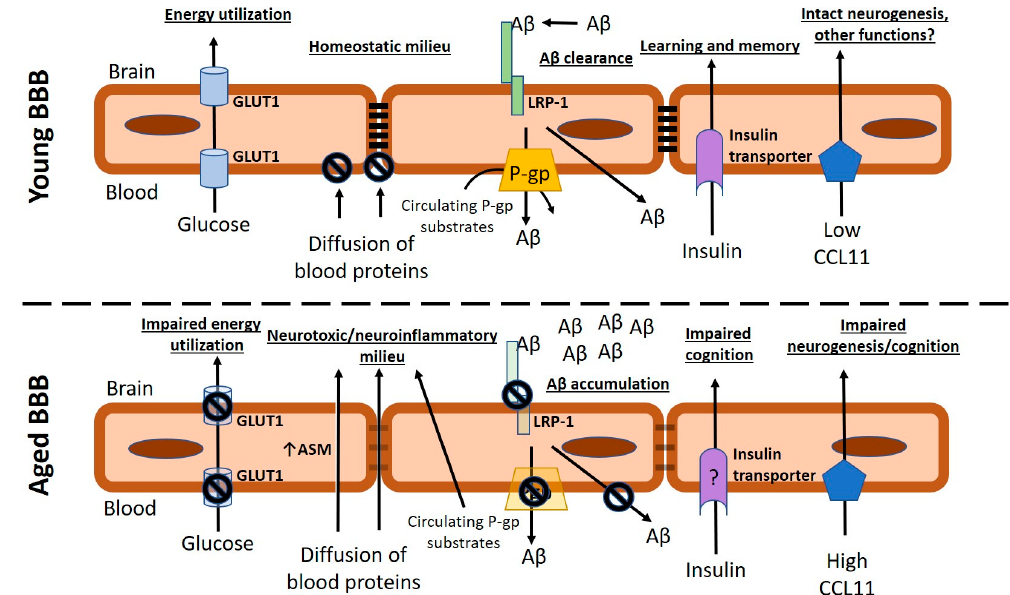
Figure 1. Changes in vascular blood–brain barrier (BBB) function that may lead to brain pathology with age. The upper panel depicts physiological functions of the BBB such as glucose transport, expression of intact tight junction complexes and suppression of vesicular processes that prevent the paracellular or transcellular leakage of blood proteins into the brain, intact functions of the efflux transporter P-gp, which contributes to barrier function by limiting diffusion of its substrates into the brain, and in concert with lipoprotein receptor-related protein 1 (LRP-1), facilitates amyloid beta (A β ) clearance from the brain. Additionally, entry of insulin into the brain supports neuronal functions and contributes to learning and memory, and brain entry of circulating compounds with high-capacity transporters such as CCL11 is limited by low circulatory concentrations. The lower panel depicts aspects of BBB dysfunction that are either supported or suggested to occur with aging. Transparent appearance of transporters (GLUT1, LRP-1, and P-gp) indicates reduced protein expression levels at the BBB, and the interdictory circles over transporters indicate known functional impairments which may occur in the presence or absence of expression changes. The question mark on the insulin receptor suggests a possible mechanism by which aging influences brain insulin through altered function of the insulin transporter, which has not yet been definitively